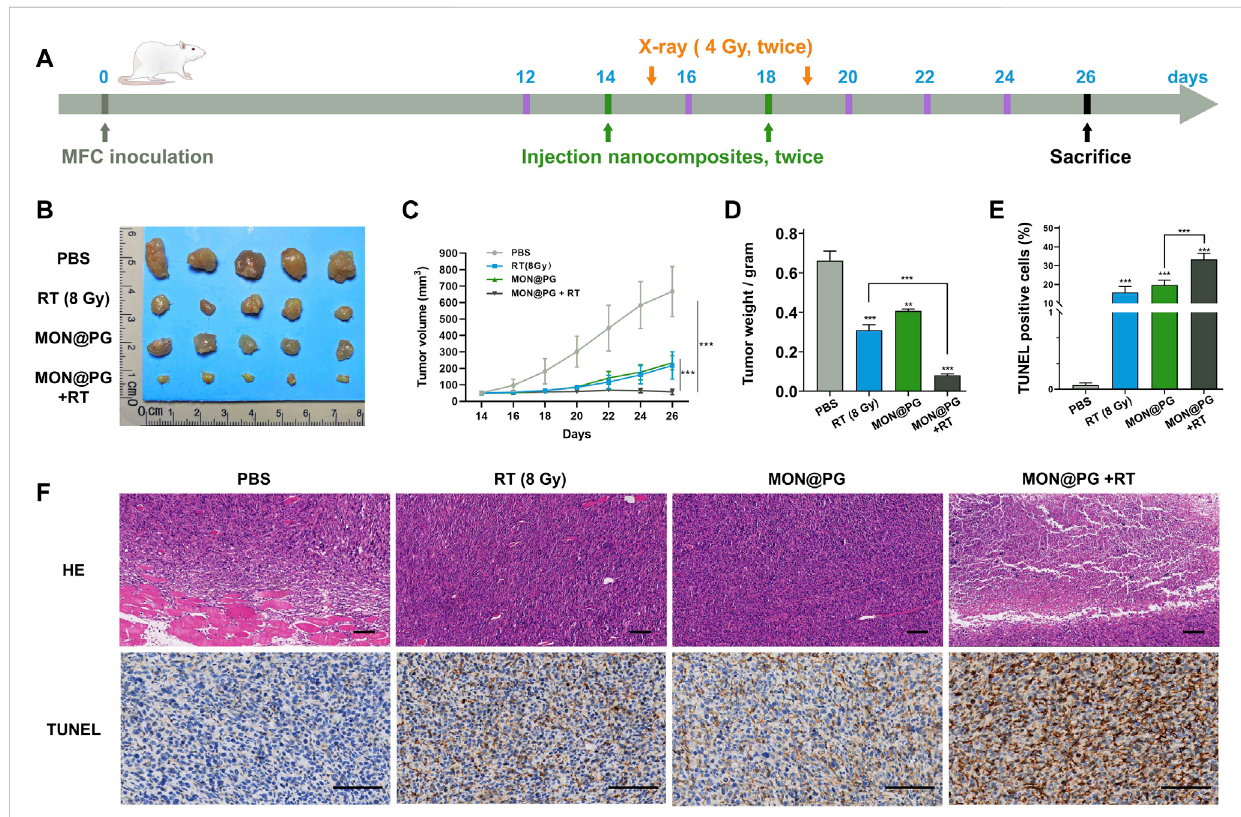
FIGURE 5 The therapeutic ef fi cacy of MON@PG combined with radiotherapy in MFC CDX models. (A) Schematic illustration of therapeutic experiments CDX models. The arrowspoint outthescheduleof tail-vein injection(green) and X-ray radiation (orange). (B) Measurements oftumormassesafter sacri fi ce in different treatment groups (n = 5). (C) Tumor volume growth curves of mice from different groups. (D) Weights of tumors from different groups. (E) QuantitativeanalysisofpercentageofTUNELpositivecells. (F)